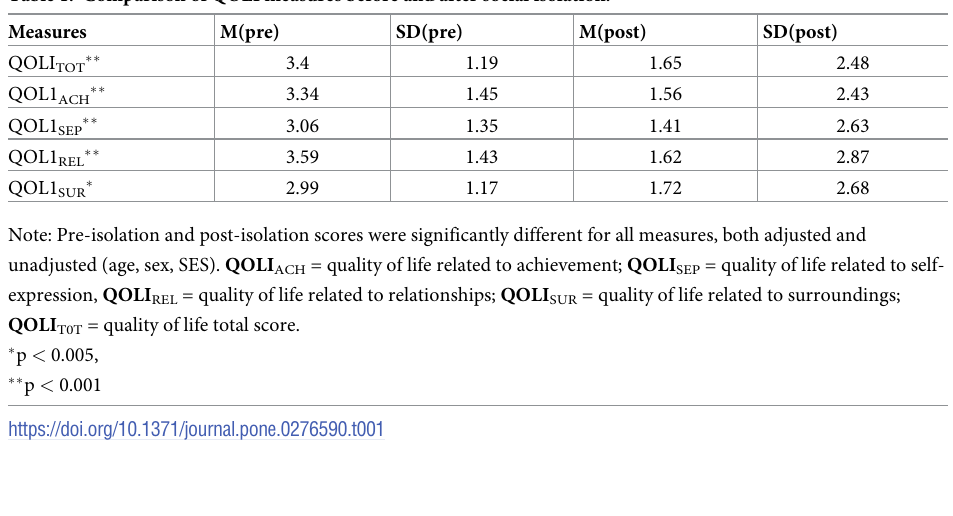
, r(62) = 0.07, p = 0.575, nor a significant ACHSUR